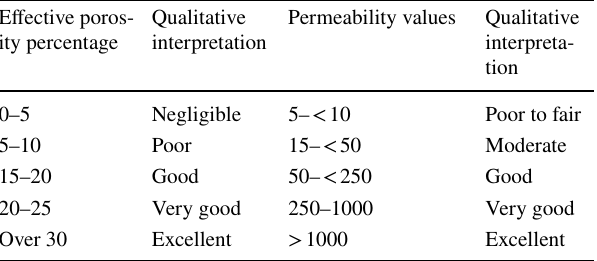
Table 3 Qualitative evaluation of effective porosity (Modified from